Question: Provide a one-line summary of what is displayed.
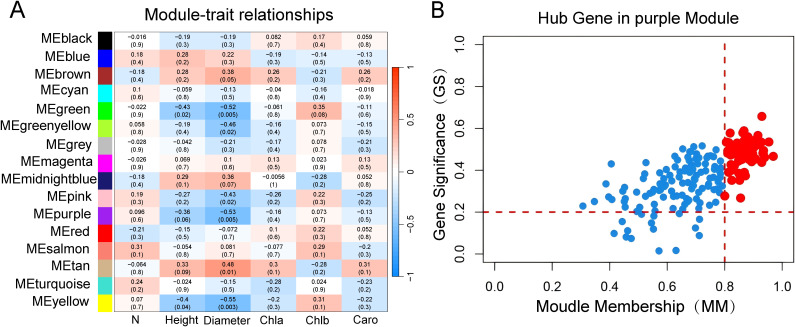
Answer: (A) Module–trait association analysis. Each row represents a co-expression module, while each column stands for a phenotypic trait. The correlation coefficient and corresponding p-value are displayed within each grid. A red color signifies a strong positive correlation, whereas a blue color represents a strong negative correlation. (B) Scatter plot illustrating gene distribution within the purple module.